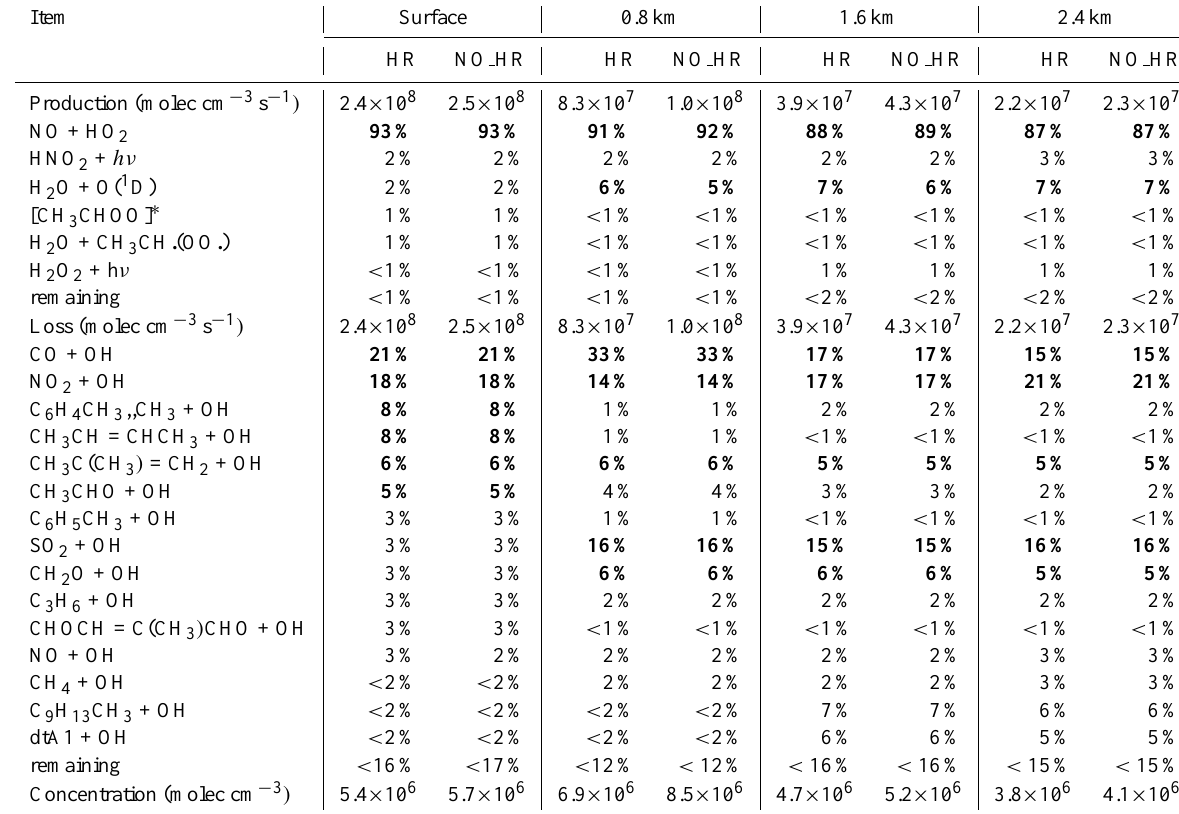
Table 4. OH budget at different altitudes based on a model analysis of measurement data with and without considering heterogeneous reactions (HR) of OH and HO 2 on aerosol